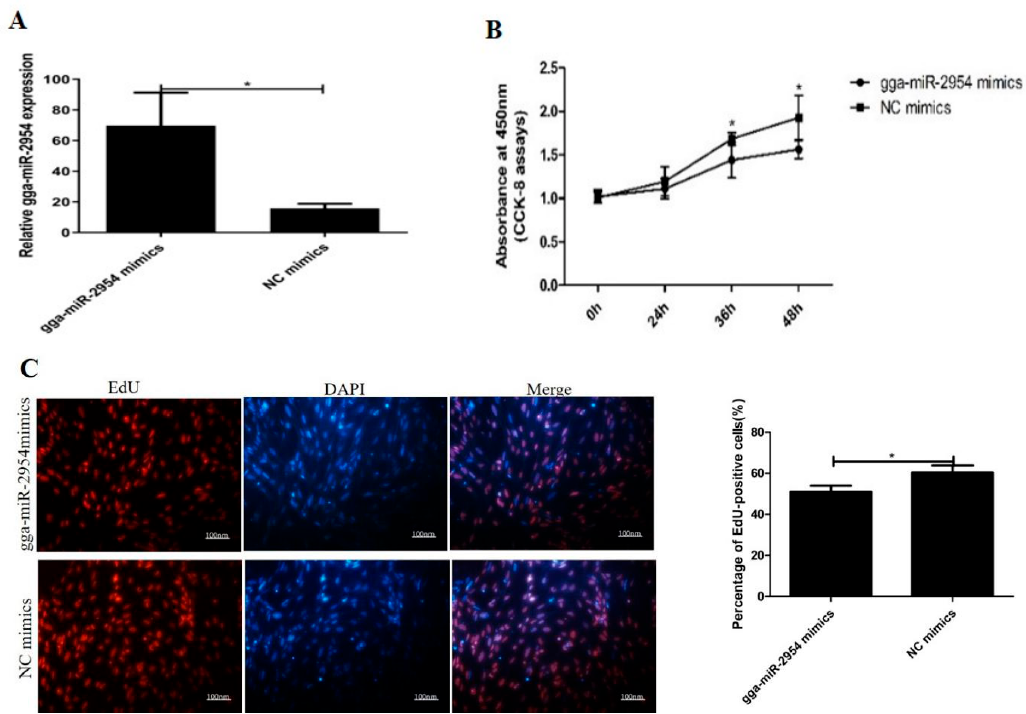
ical map of chicken primary myoblasts during proliferation (50% and 100% growth density, 50% GM and 100% GM)